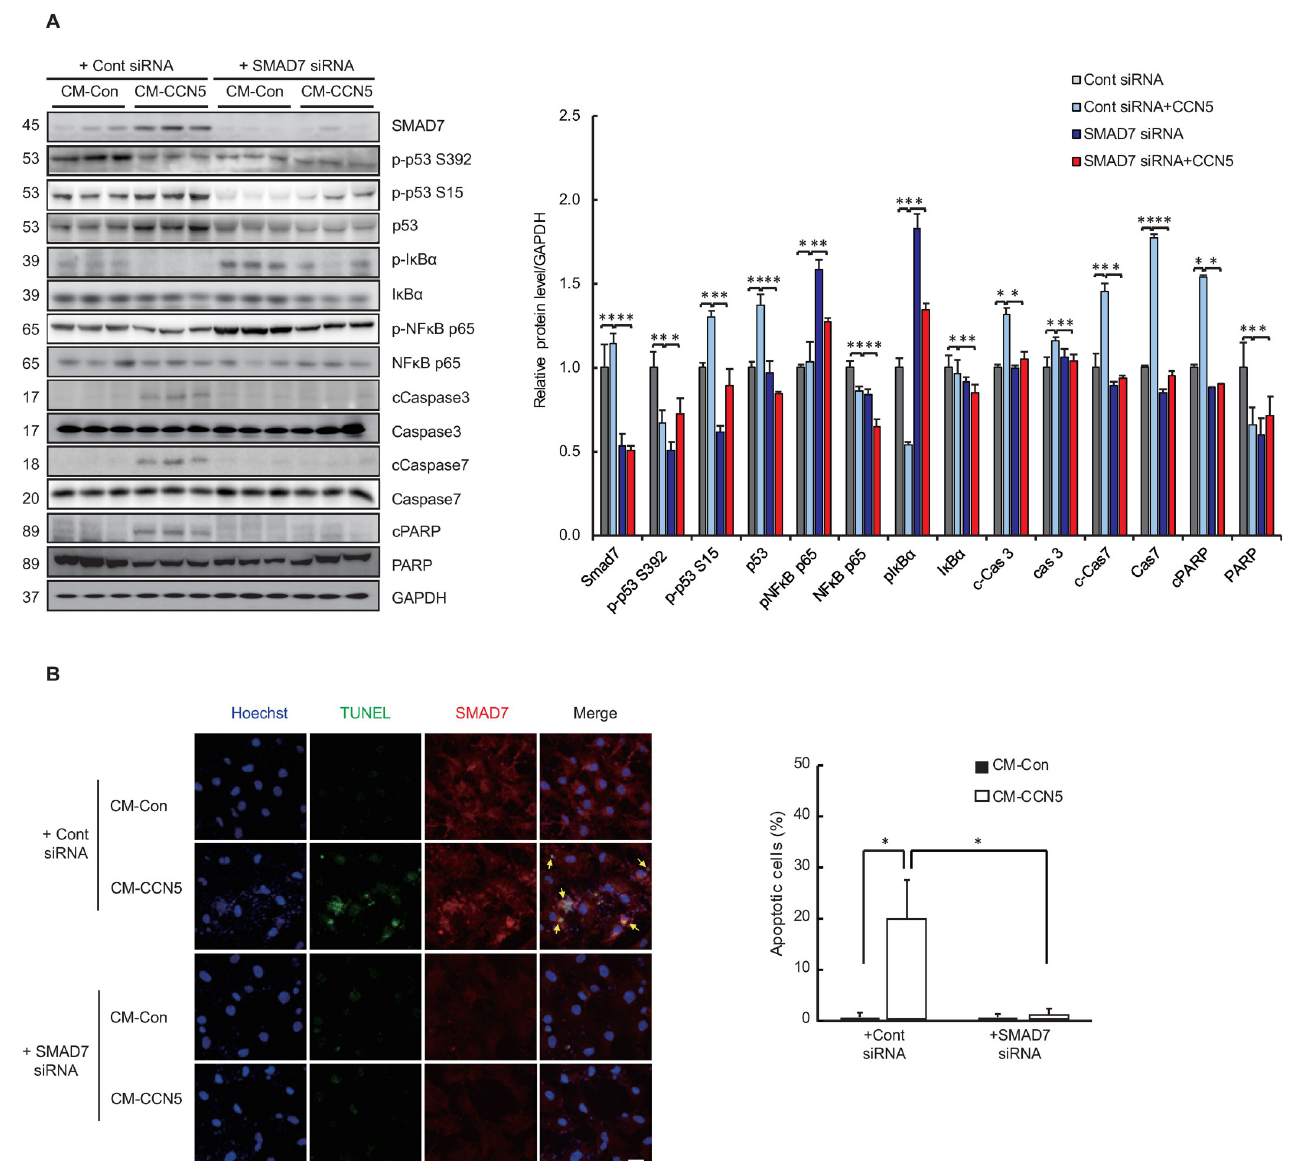
Fig 4. CCN5 inhibits NF κ B signaling through elevation of SMAD7 levels. Freshly prepared FBs were transfected with 25 nM SMAD7 siRNA and were trans- differentiated to MyoFBs by treating them with 10 ng/mL TGF- β for 48 hours. MyoFBs were then cultured in control conditioned media (CM-Con) or CCN5-containing conditioned media (CM-CCN5) for a further 48 hours. (A) Cell lysates were used for western blotting analysis of SMAD7, p53, phosphorylated p53 (p-p53 S15 or p-p53 S392), NF κ B p65, phosphorylated NF κ B p65 (p-NF κ B p65), I κ B, phosphorylated I κ B (p-I κ B), caspase 3 (Cas3), cleaved caspase 3 (c-Cas3), caspase 7 (Cas7), cleaved caspase 7 (c-Cas7), Poly (ADP-ribose) polymerase (PARP), and cleaved PARP (cPARP). GAPDH was used as a loading control. (B) Cells were co-stained with TUNEL (green) and p53 (red). Hoechst dye was used for nuclear staining. TUNEL-positive apoptotic cells were counted and plotted. Scale bar is 50 μ m. For each group, three independent cultures were prepared and treated (n = 3). � P < 0.05, �� P <